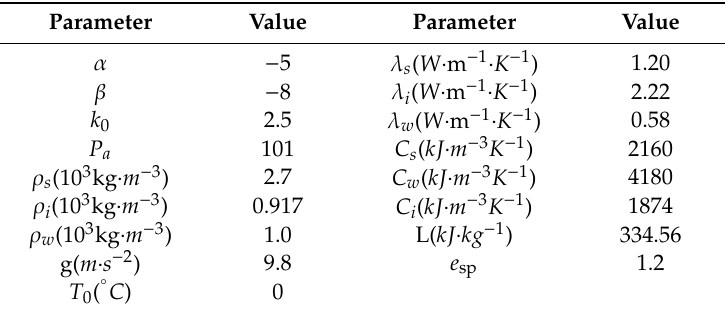
Table 1. The calculated